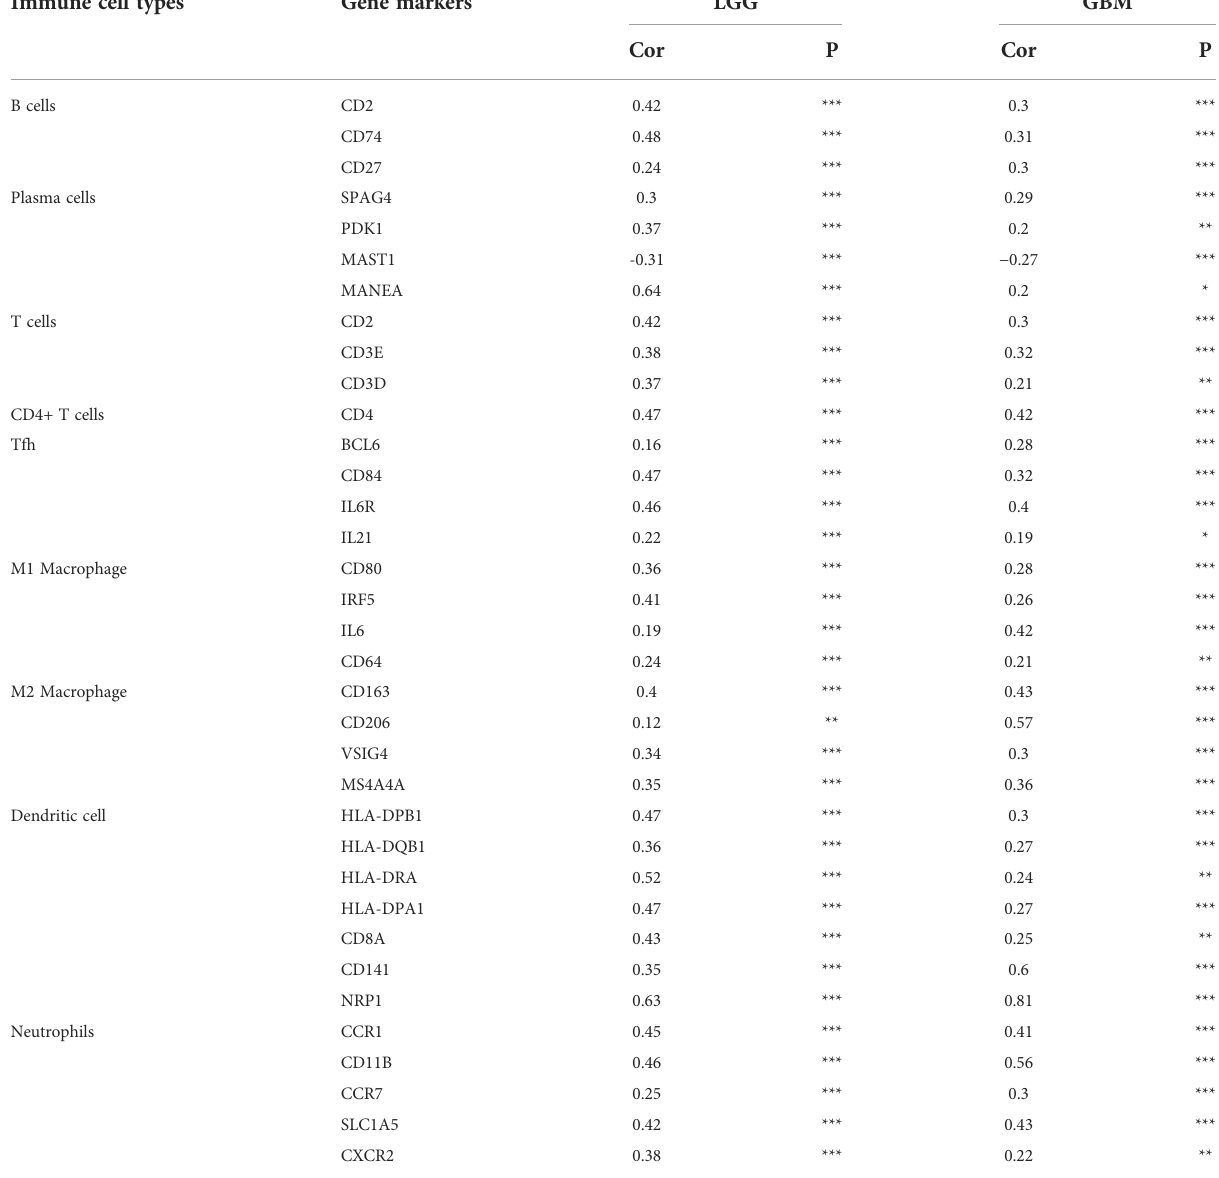
TABLE 4 Correlation analysis between FNDC3B expression and gene markers of immune cells in Gene Expression Pro fi ling Interactive Analysis 2 (GEPIA2). Immune cell